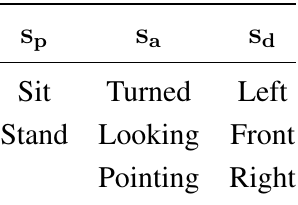
Table 1. Semantic values of G . In order to be considered a valid sentence of G , the p p sentence must include one semantic value from each column. If the received sentence is valid for G , then the sentence is defining a pose. Note that G defines the 18 poses ( 2 × 3 × 3 ) p p that the robot can understand and, therefore,